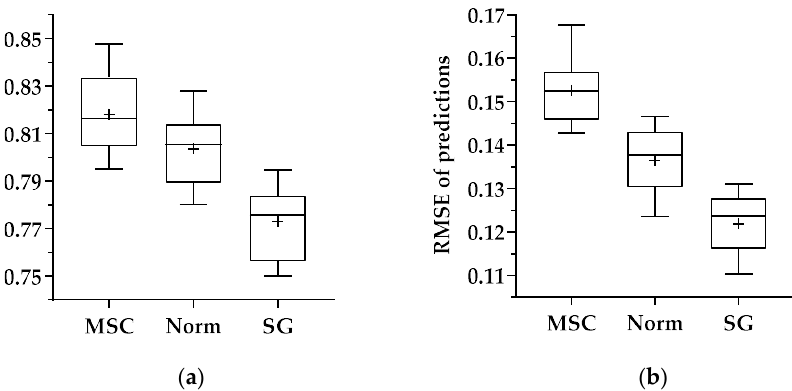
Figure 4. RMSEs of predictions for each preprocessing technique regarding the 1D CNN created and then applied to test samples for ( a ) sugar measurements and ( b ) pH measurements. The boxes represent the 25th, 50th, and 75th percentiles, the whiskers represent the minimum and maximum values, and the plus symbol denotes the mean reference values.